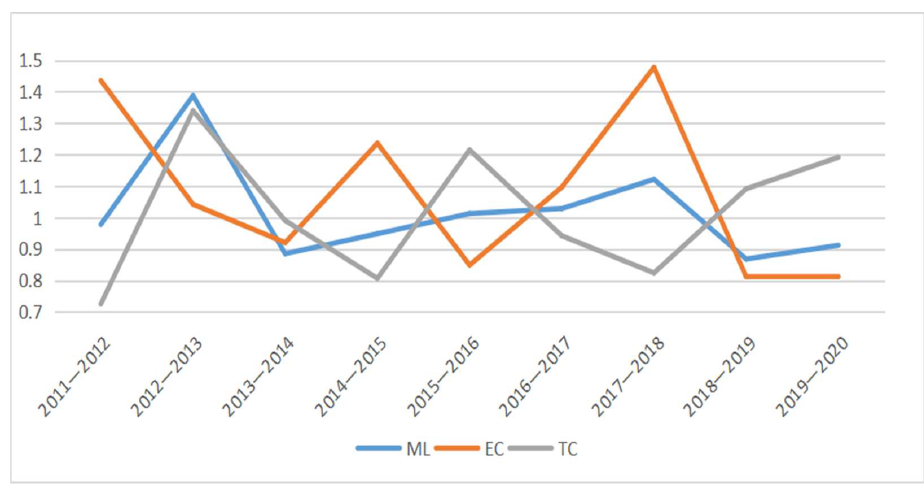
Figure 1. Time trend of the mean and decomposition of the Malmquist Index.